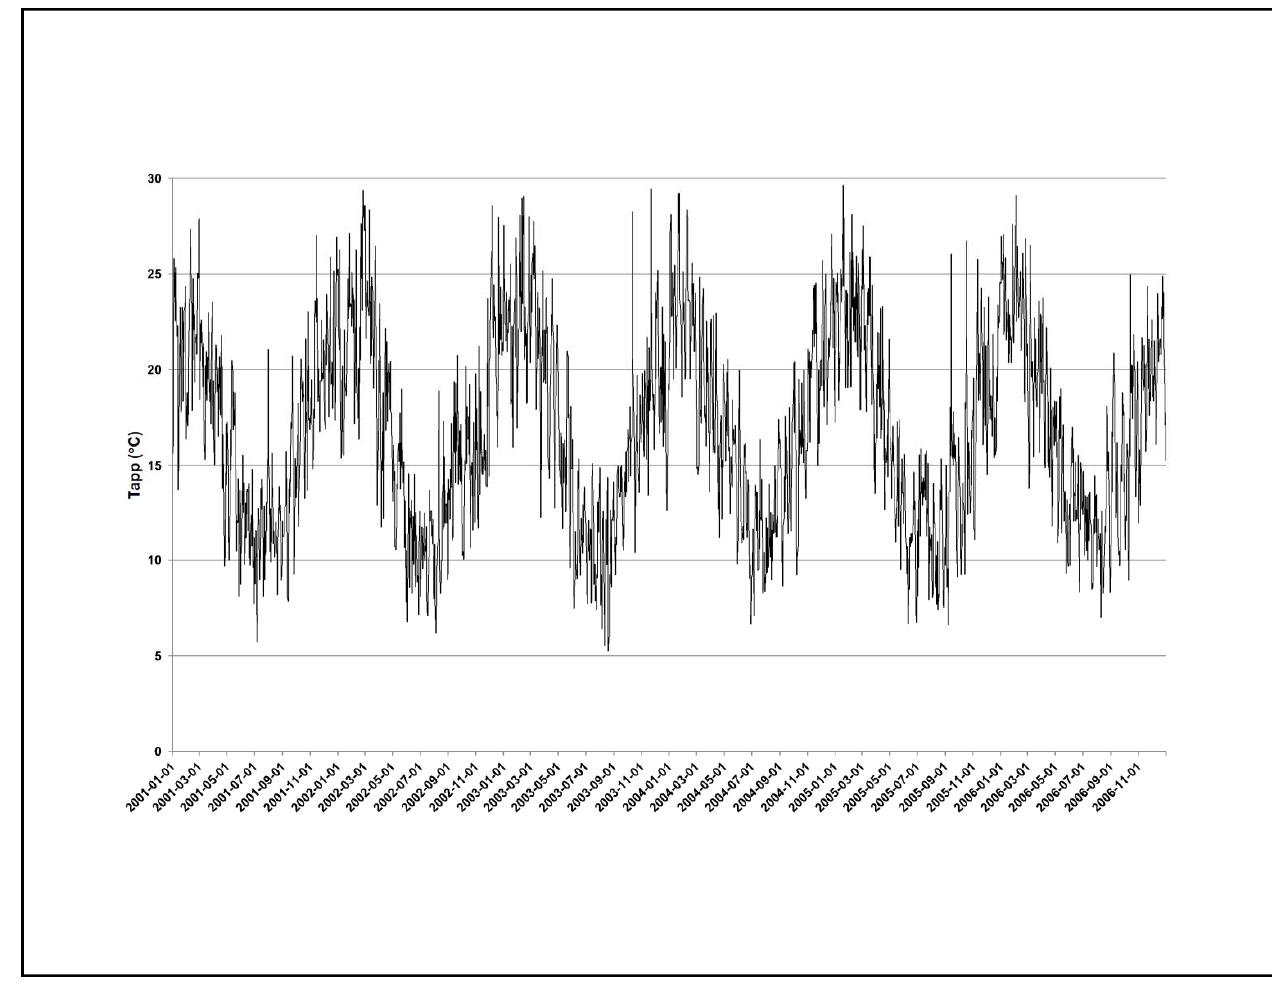
Figure A4. Time series of Tapp ( a ), rainfall ( b ) and wind speed ( c ) in Cape Town during 1 January 2001–31 December